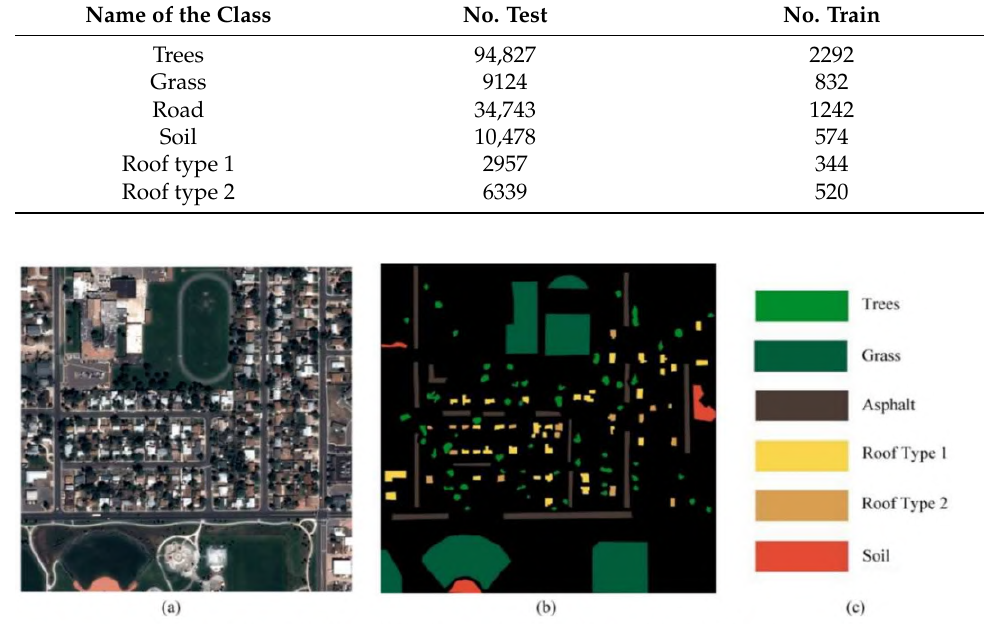
Figure 5. ( a ) Pleiades subset ( b ) Ground reference ( c )